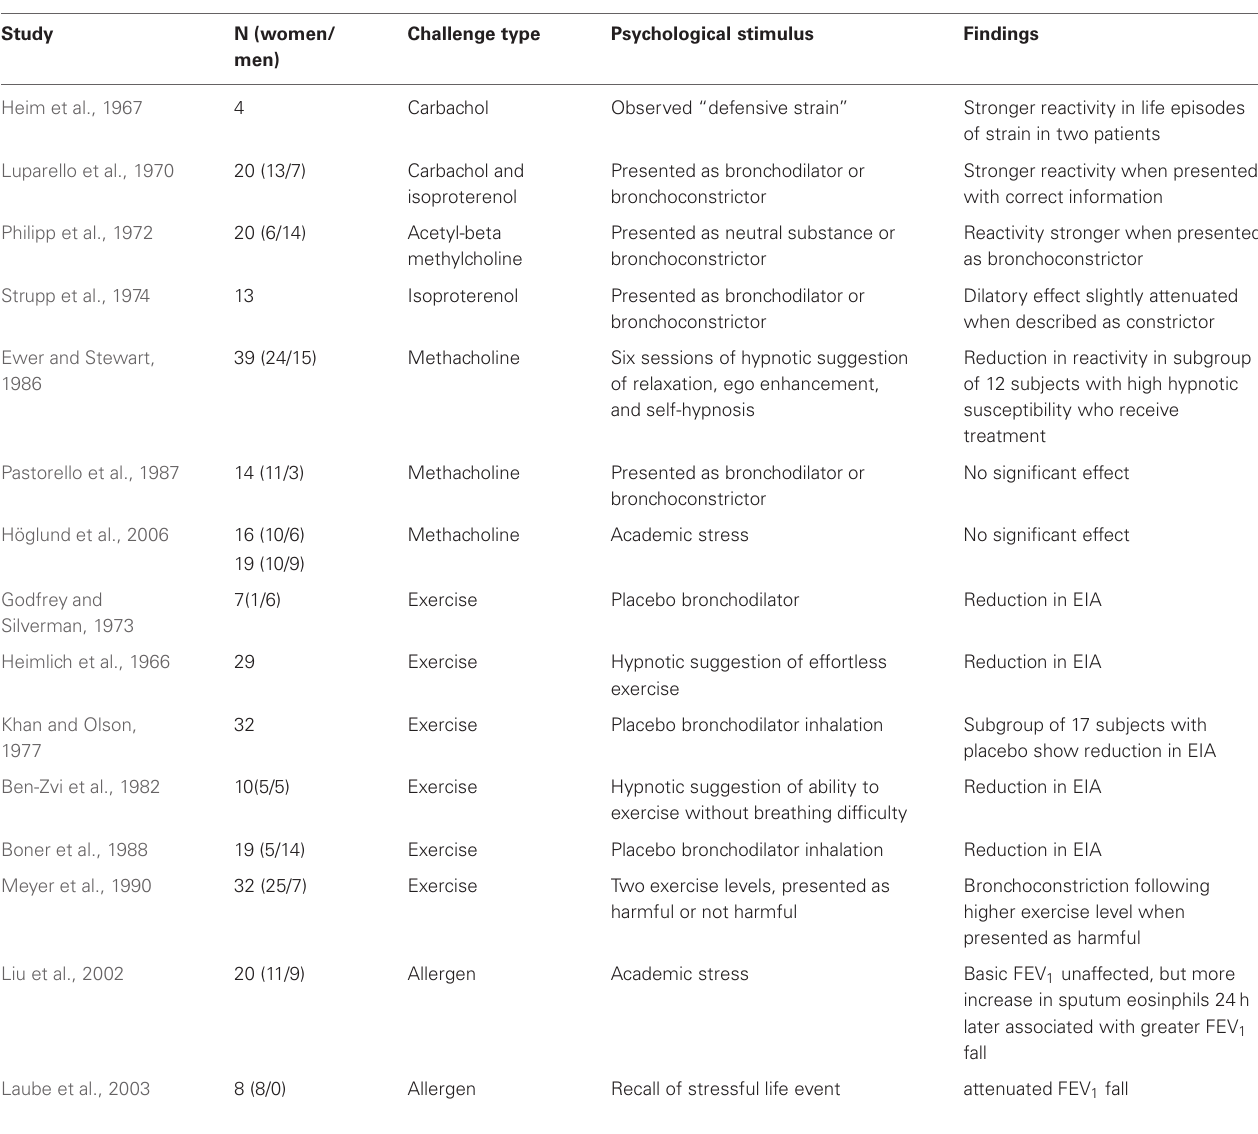
Table 1 | Effects of psychological stimuli on airway responses to pharmacological or physical challenge. Study N